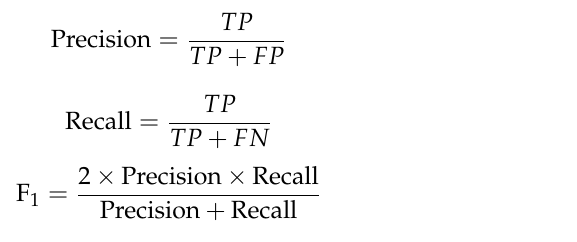
Table 3. The performance results of the compared methods.